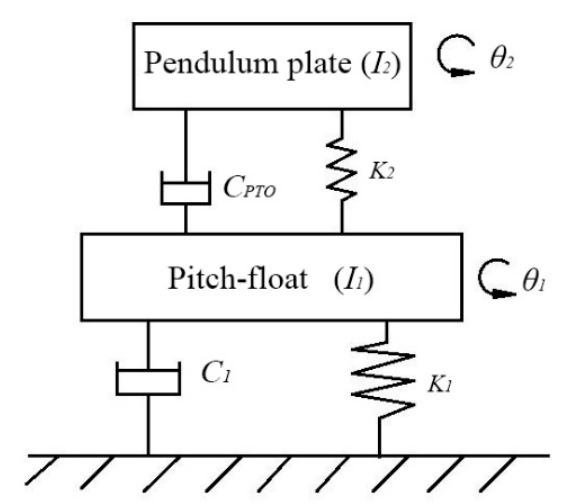
Figure 1. A dynamic model of the pitch-float wave energy converter.